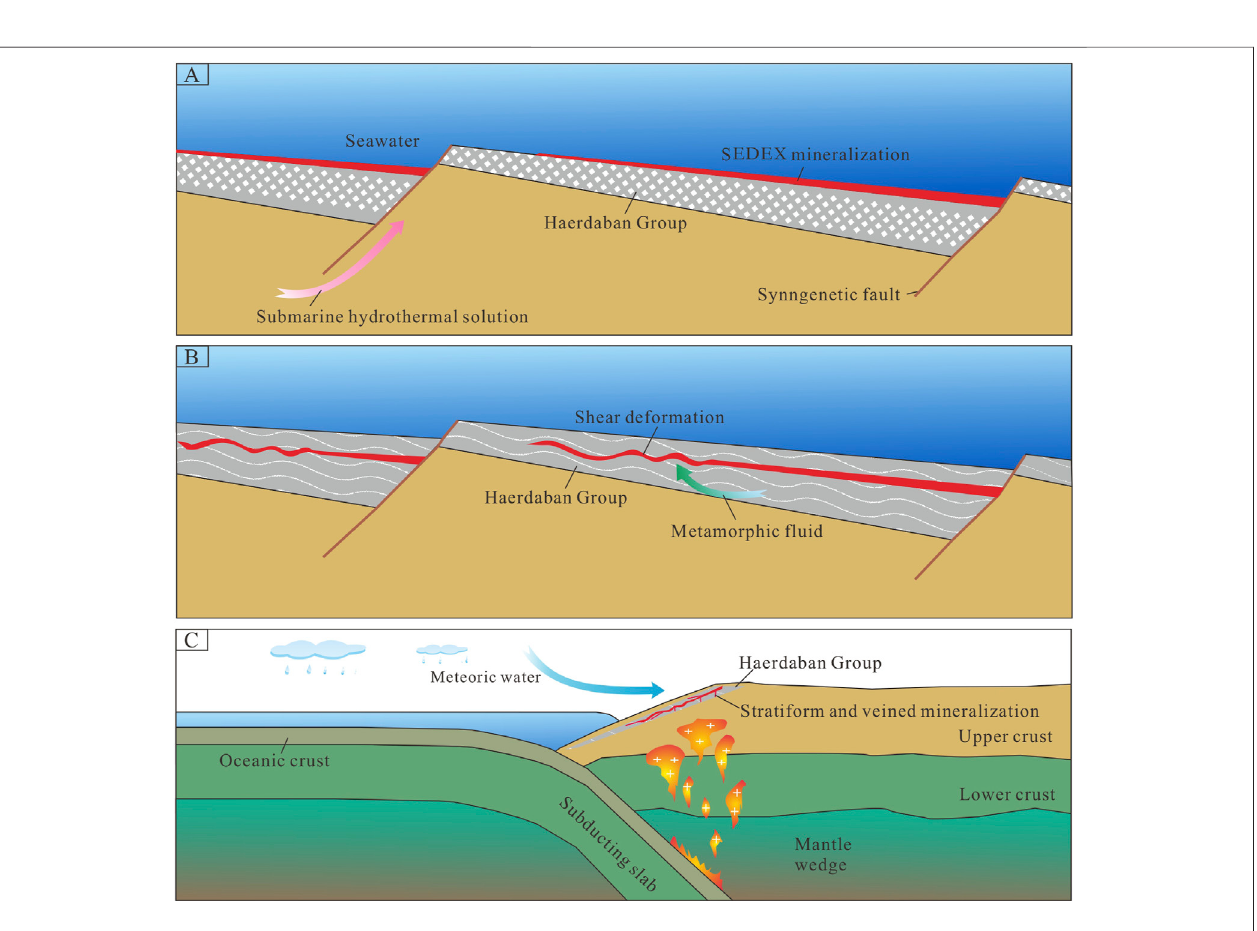
FIGURE 9 | Genetic model of the Haerdaban Pb-Zn